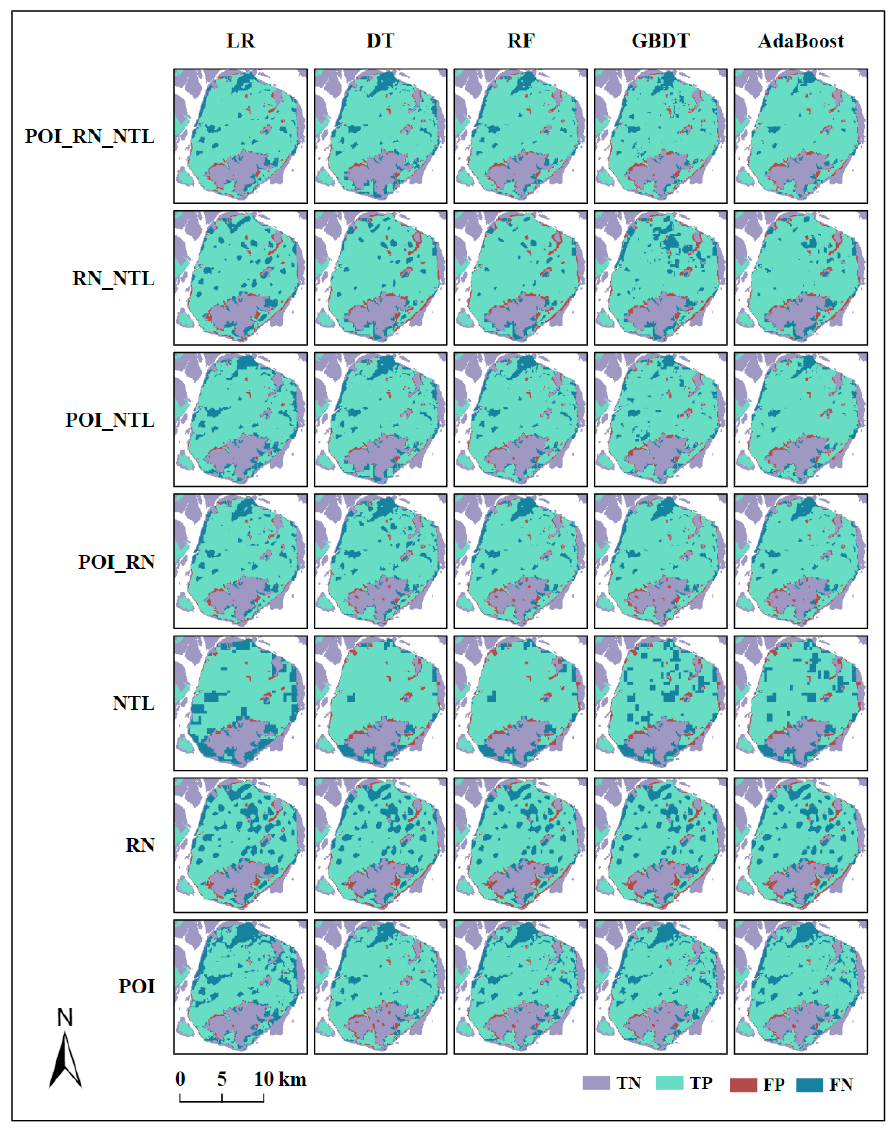
Figure 7. Results of the built-up area intelligent classification (BAIC) system using different input data and classifiers. TP: True Positive. FP: False Positive. FN: False Negative. TN: True Negative.